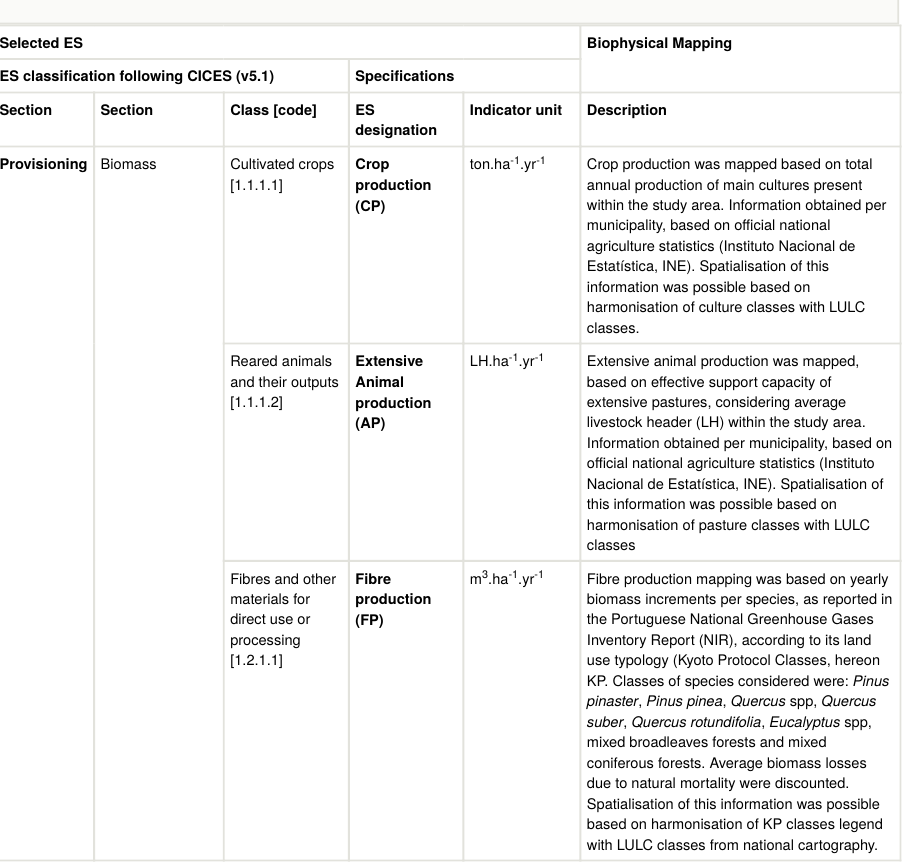
Final selection of ES (classi fi cation following CICES and speci fi cations for this study) and brief description of biophysical mapping methods